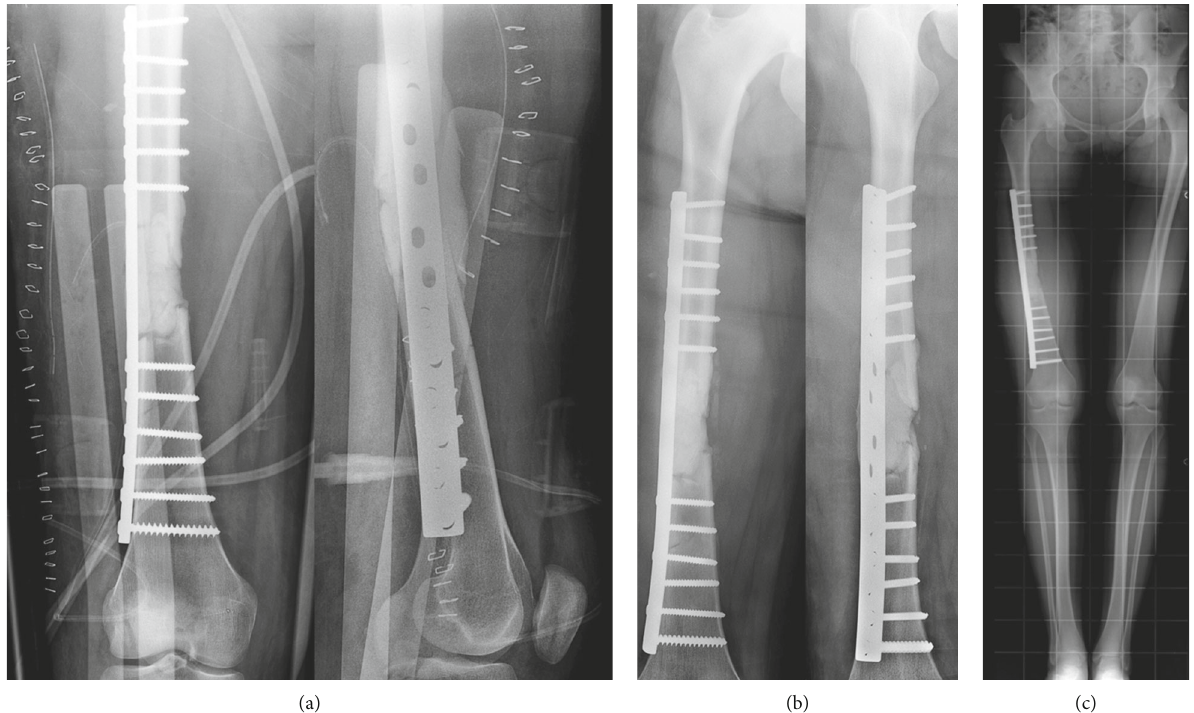
Figure 2: After a surgical debridement comes the fi rst stage of the modi fi ed Masquelet technique. (a) The large defect was fi lled with cement, and the fracture was stabilized with a 4,5mm Dynamic Compression Plate. (b) Follow-up views at 4 weeks post fi rst stage. (c) At the full- length weight-bearing (FLWB) X-ray, there was no leg length discrepancy.